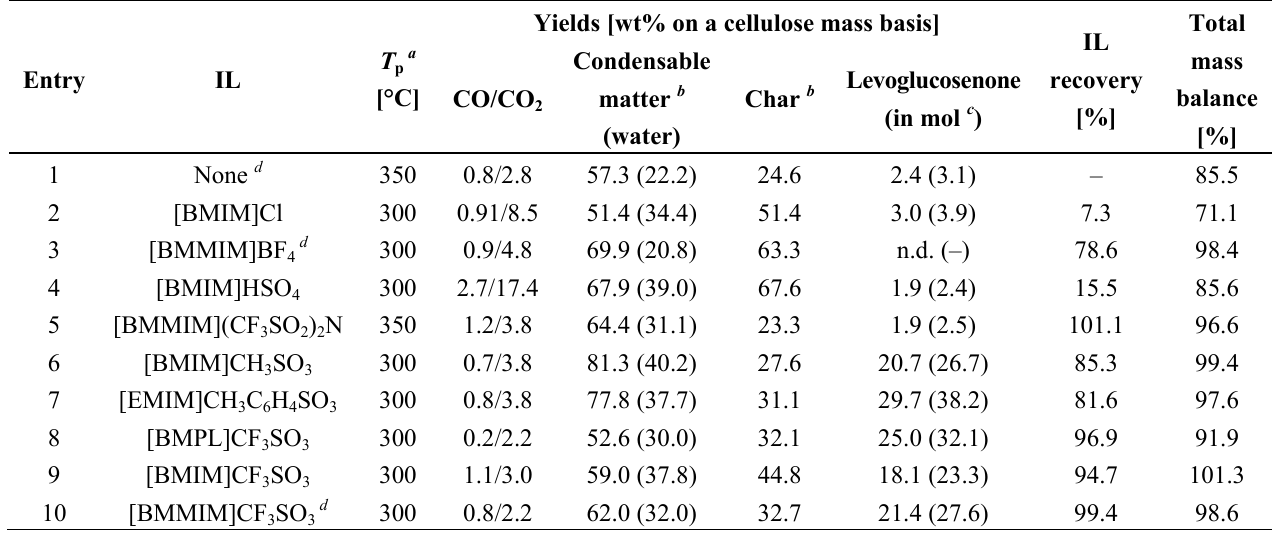
Molar yield of levoglucosenone per molar number of D -glycopyranose units calculated from weight